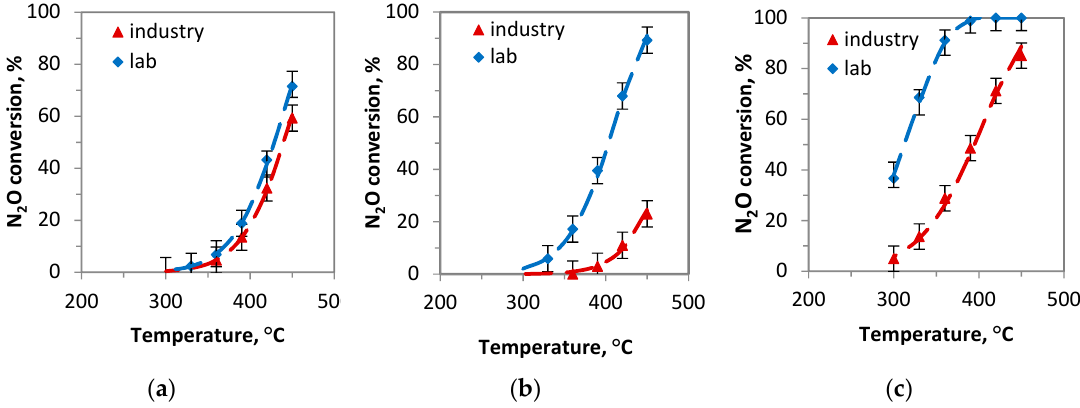
Figure 3. N 2 O decomposition over laboratory and commercially prepared catalysts in grain form: ( a ) K/Co 4 MnAlO x ; ( b ) Cs/Co 4 MnAlO x ; ( c ) Cs/Co 3 O 4 . Points—experimental data; dashed line—model (Equation (2)). Conditions: 1000 ppm N 2 O + 5 mol% O 2 + 2 mol% H 2 O in N 2 , GHSV = 60,000 l kg − 1 h − 1. Table 1. Kinetic constants and reaction rates of N 2 O catalytic decomposition over laboratory (grain form) and commercially prepared (grain and pellet forms) catalysts and estimated